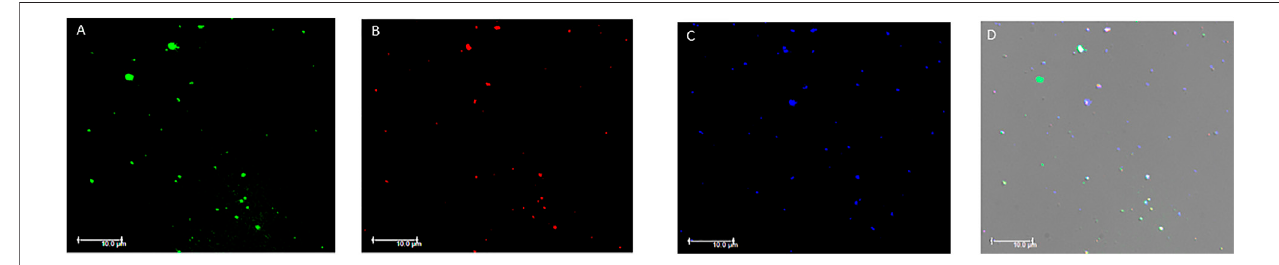
FIGURE 4 | Fluorescence microscopy images of plasma extracellular vesicles. (A) Calcein-AM FITC staining (green fl uorescence); (B) anti-human TF staining (red fl uorescence); (C) anti-human ACE2 staining (blue fl uorescence). (D) Overlay of the three fl uorescence images and differential interference contrast (DIC). MVs were isolated from plasma and images acquired by fl uorescence microscopy (Leica DMI6000CS, 100x/1.4 oil immersion objective) using a DFC365FX camera and LAS-AF 3.1.1. software. Scale bar 10 μ m; Abbreviations: FITC: Fluorescein; TF: tissue factor; ACE2: angiotensin-converting enzyme-2.